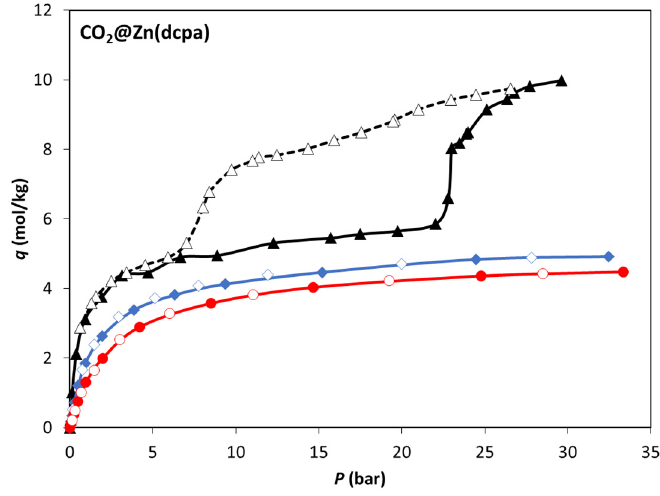
Figure 5. Absolute adsorption equilibrium isotherms of CO 2 on Zn(dcpa) at 273 K ( ▲ ), 303 K ( ♦ ), and 323 K ( ● ). Filled and empty symbols represent adsorption and desorption experimental data, respectively.